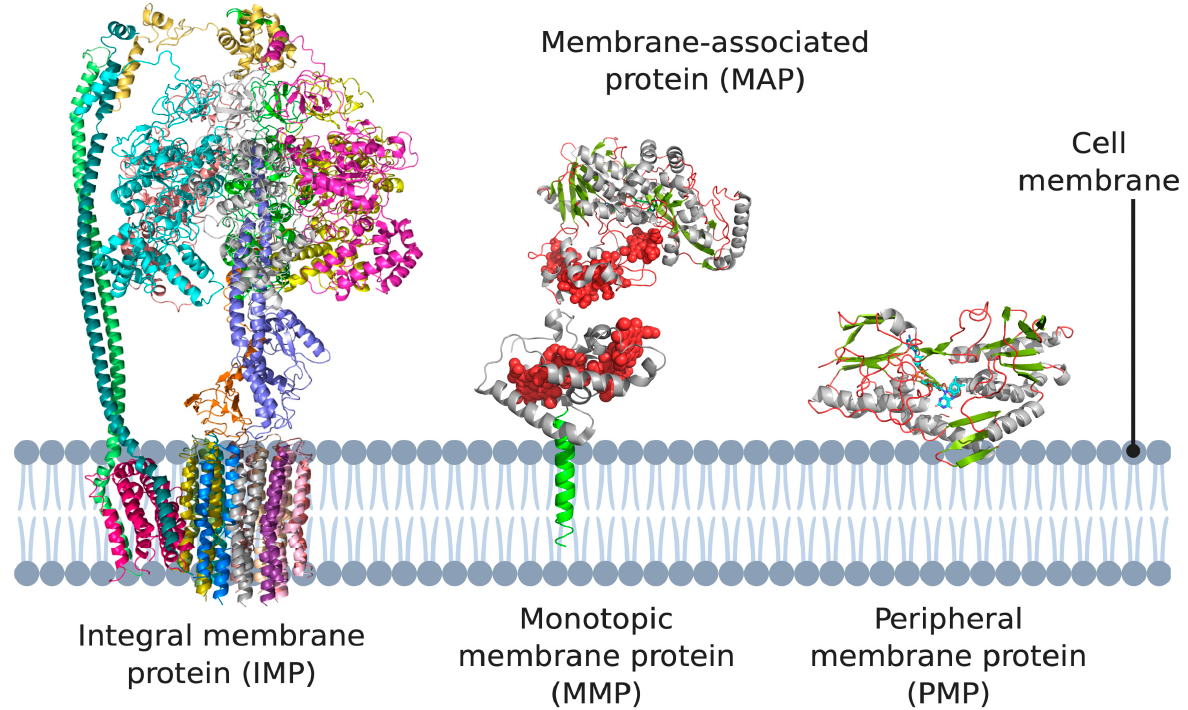
Figure 1. Different types of membrane proteins shown in the cell membrane. Integral membrane proteins are shown to span the entire membrane (Escherichia coli ATP synthase as example). Peripheral membrane proteins can be categorized into two subtypes: proteins that only associate with the membrane via electrostatic or hydrophobic interactions ( Caldalkalibacillus thermarum type-II NADH dehydrogenase as example), and proteins that anchor themselves in the lipid bilayer using a hydrophobic segment that does not span the entire membrane ( Desulfovibrio vulgaris NrfH as example). 3D structural cartoons of E. coli ATP synthase (PDB:5T4Q) [4], D. vulgaris NrfH (PDB:2J7A) [5], Shewanella frigidimarina flavocytochrome c 3 (PDB:1Y0P) [6], and C. thermarum NDH-2 (PDB:6BDO) [7] were rendered with PyMol and the figure compiled in BioRender.com [8].